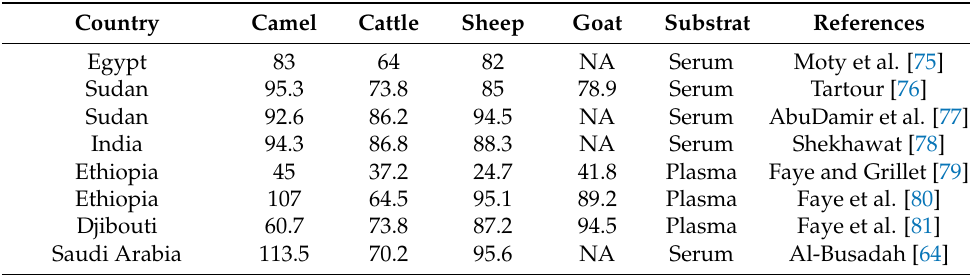
Table 1. Comparative mean concentrations of copper in the plasma or serum of domestic ruminants (in µ g/100 mL). Country Camel Cattle Sheep Goat